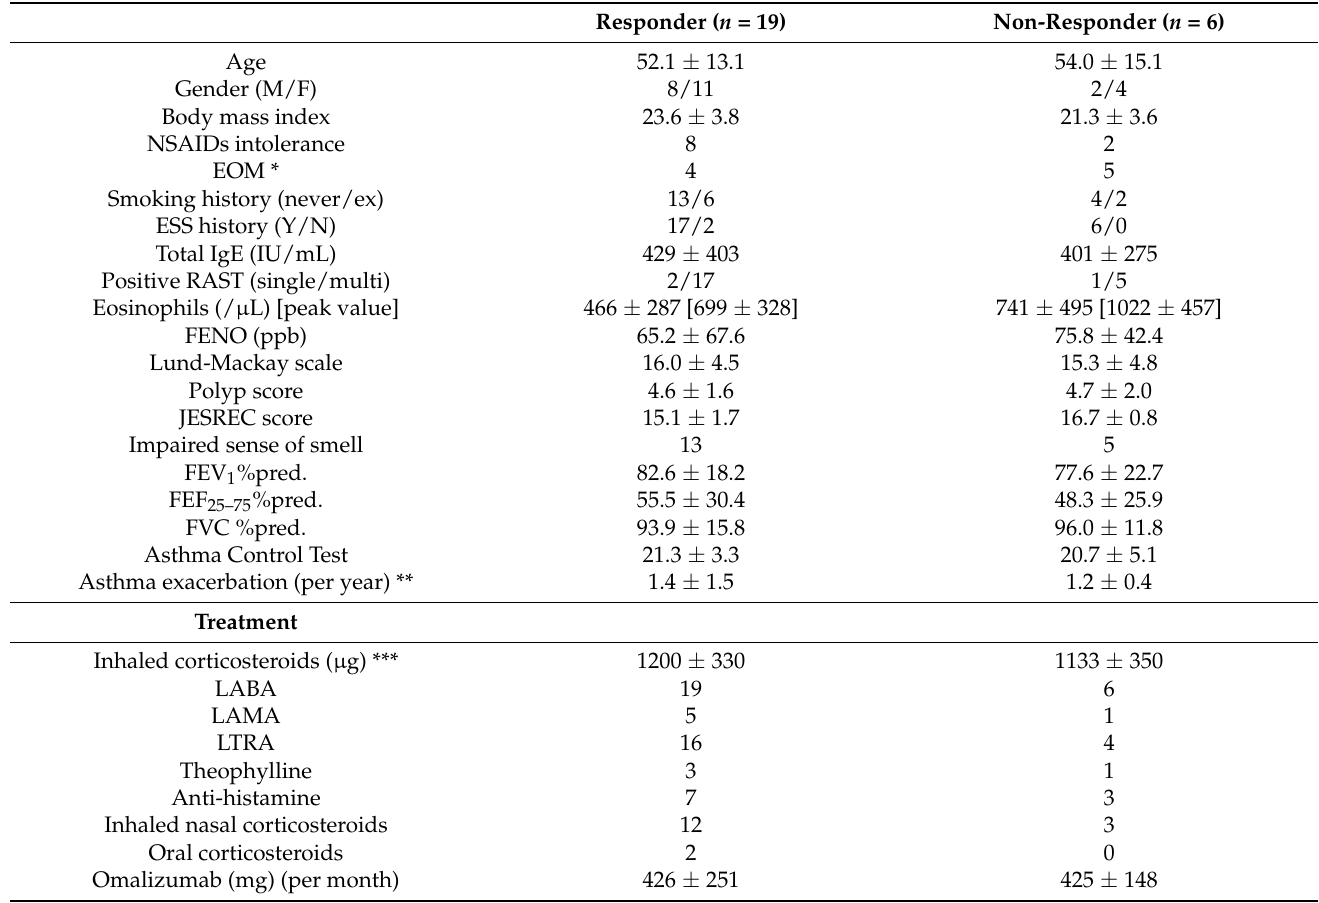
Table 1. Patients’ baseline